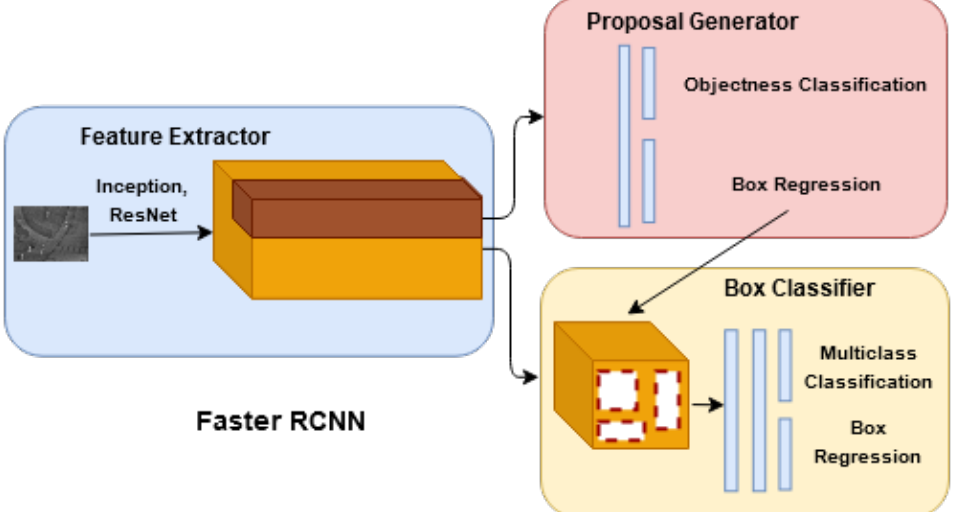
Figure 3. Faster R-CNN approach for object